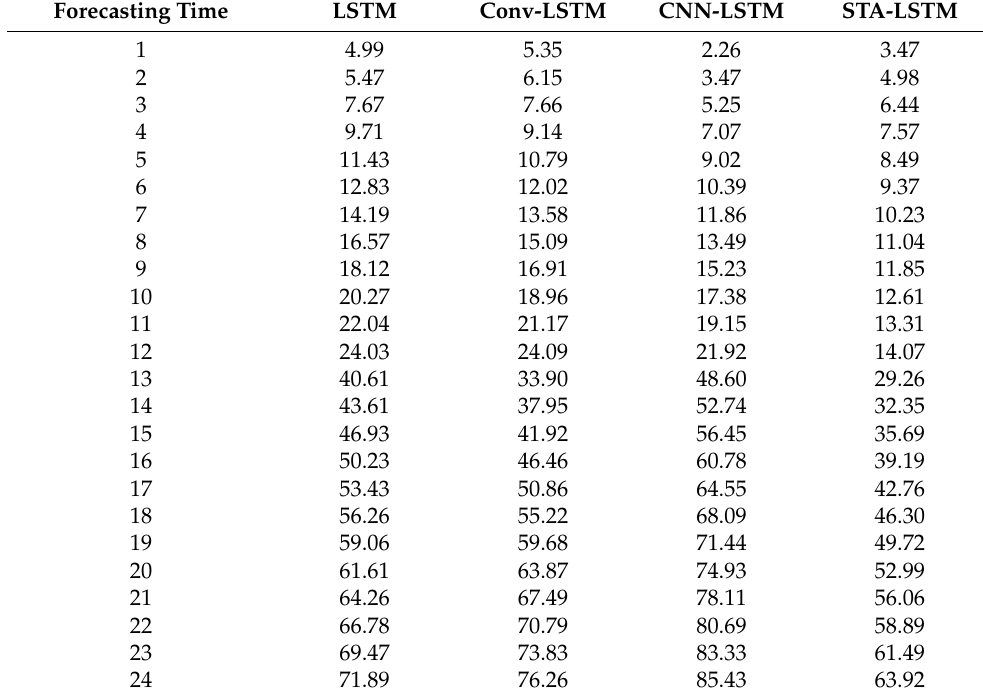
Table 1. Mean Square Error of the proposed models’ performance.